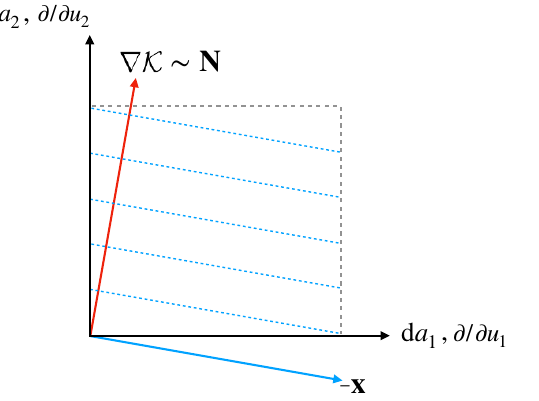
Figure 2 . Light axion direction (aligned with a 1 axis) vs. (cid:13)ux vector N and K(cid:127)ahler potential gradient rK (aligned with orthogonal